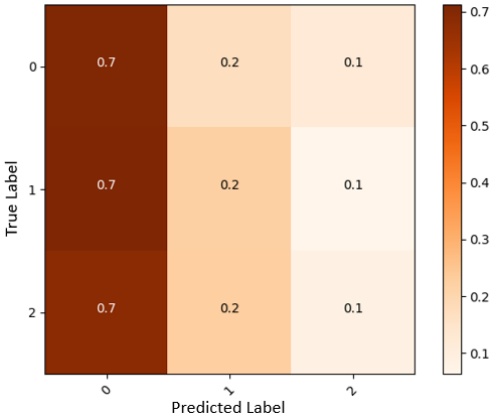
Figure 11. Confusion matrix from a patient with CMT